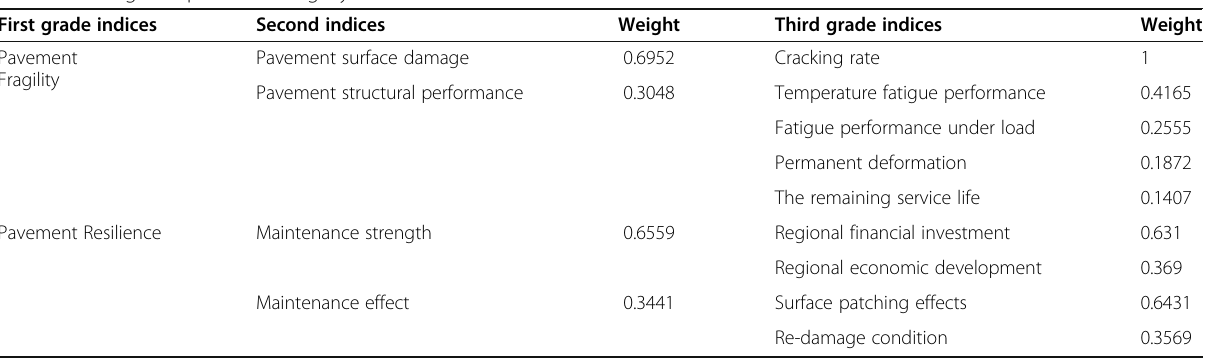
Table 11 Weight of pavement fragility index and resilience